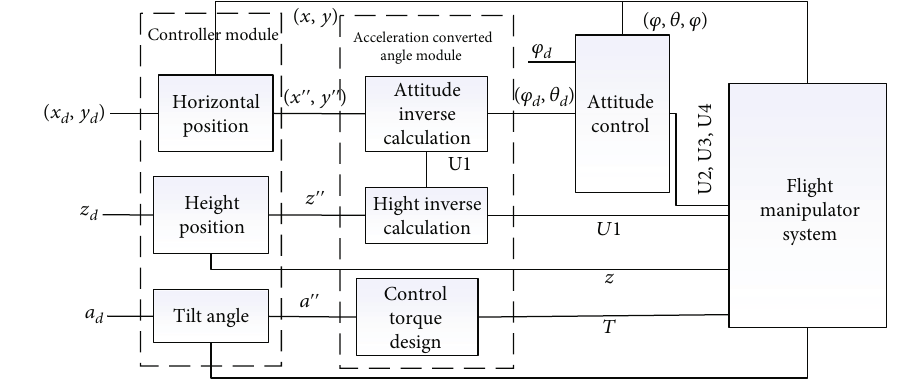
Figure 8: Control fl ow